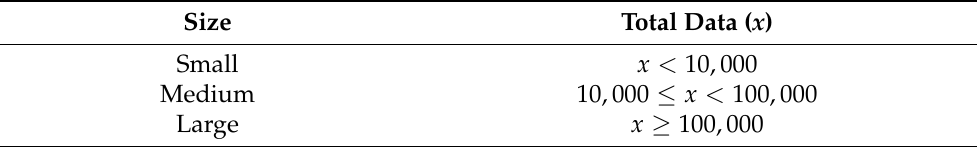
Table 2. Instance size based on total